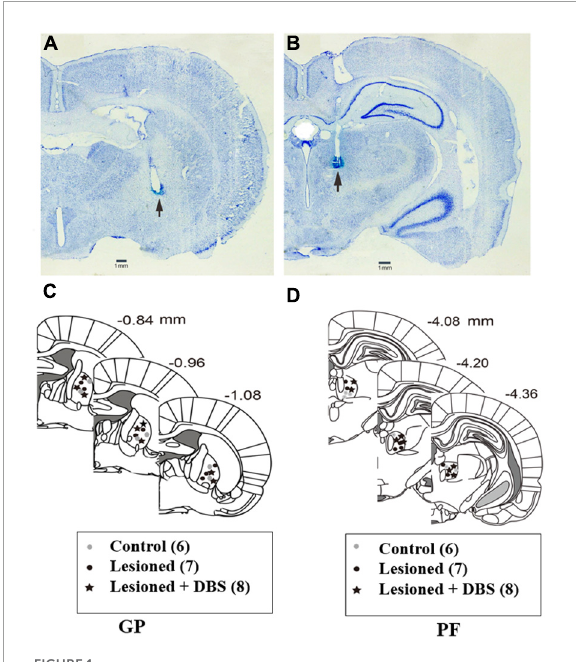
FIGURE1 Two representative examples of neutral Nissl-stained coronal sections of a rat brain are pointing to the tip of a stimulating electrode in the GP (A) and the recording electrode in the PF (B) . Black arrows indicate the locations of the electrodes’ tips. Schematic reconstructions adapted from Paxinos and Watson (2007) represent the sites of the stimulating electrode tip in the GP (C) and the recording electrode tip in the PF (D) . Control: control rats (gray circles); Lesioned: 6-OHDA-lesioned rats (black circles); Lesioned + DBS: 6-OHDA-lesioned rats with DBS (stars). The number beside each schematic indicates the distance from bregma in the anteroposterior plane.